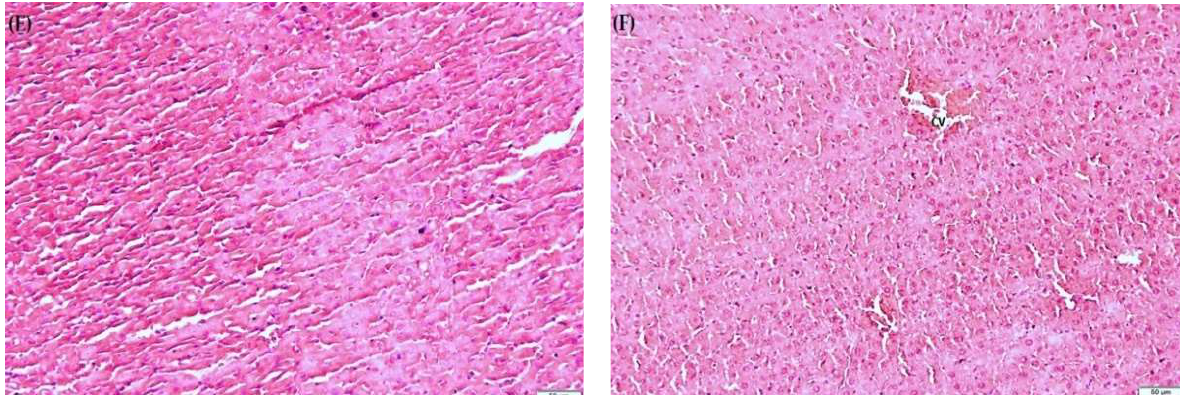
Figure 2. Photomicrographs of rat liver sections stained with haematoxylin and eosin from each group. Total magnifications 10×. ( A ) Control group, normal histology. ( B ) CCl 4 (1.0 mL/kg bwt)-induced necrosis, fatty acid degeneration, derangement of hepatocytes. ( C ) F. lepicarpa (100 mg/kg bwt + CCl 4 ); slight repairing of hepatocytes. ( D ) F. lepicarpa (200 mg/kg bwt + CCl 4 ) repairing of hepatocytes. ( E ) F. lepicarpa (400 mg/kg bwt + CCl 4 ); repairing of hepatocytes. ( F ) F. lepicarpa (400 mg/kg bwt) (normal histology).